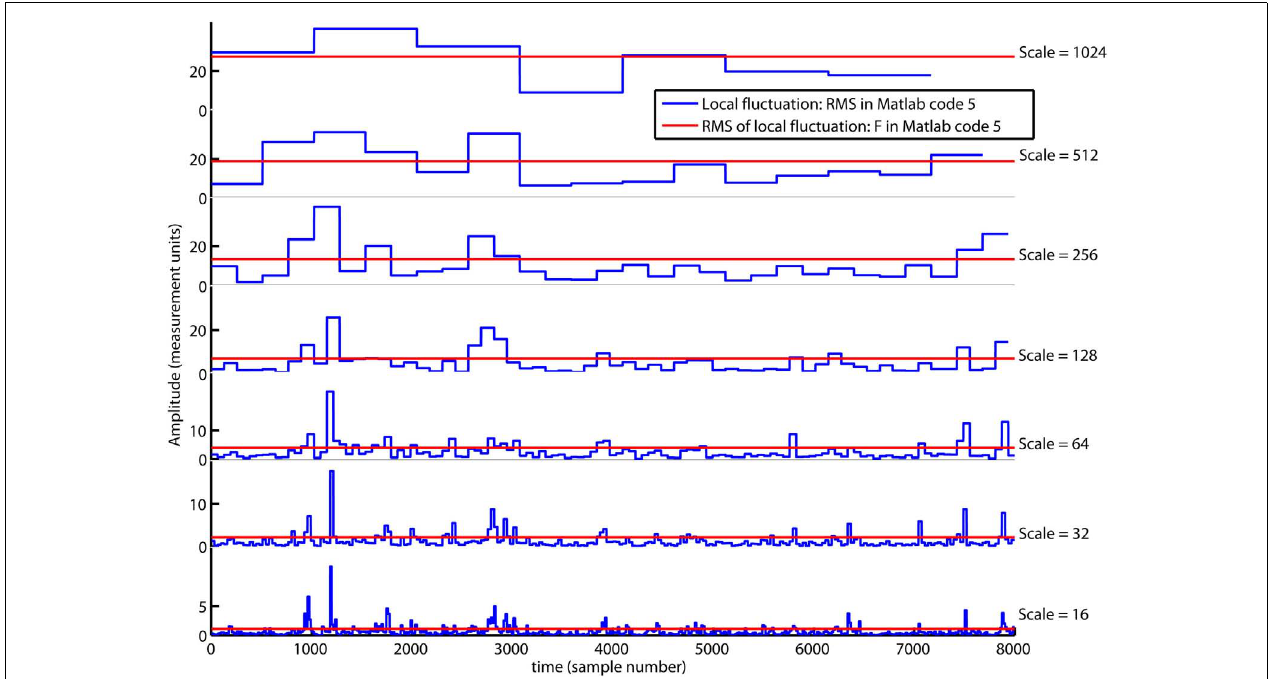
FIGURE 4 |The local fluctuations, RMS{ns} ( blue lines ), computed by Matlab code 5 for segments with multiple segment sizes (i.e., scale). The